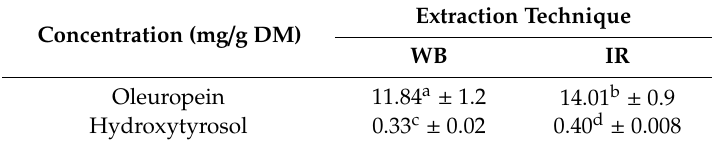
Table 6. Oleuropein and hydroxytyrosol concentrations (mg / g DM) in WB and IR olive leaf